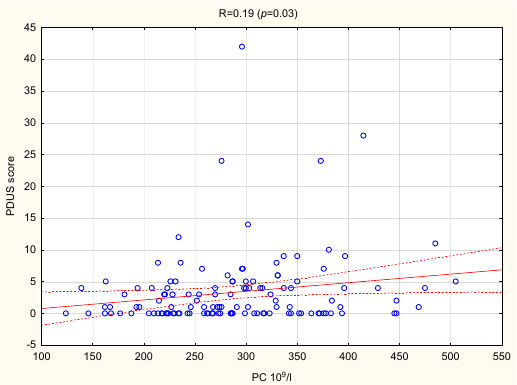
Figure 2. Correlation between PC and PDUS score in patients with RA. PC, platelet count; PDUS, power doppler ultrasound; RA, rheumatoid arthritis.